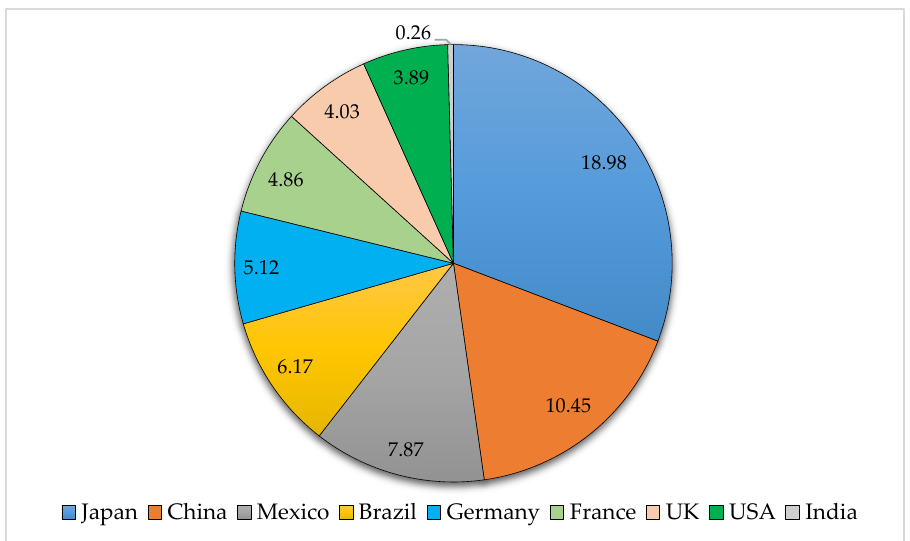
Figure 3. Total averaged pesticide use per year (Kg/ha) during 2010–2014 (Obtained from Zhang [46]).